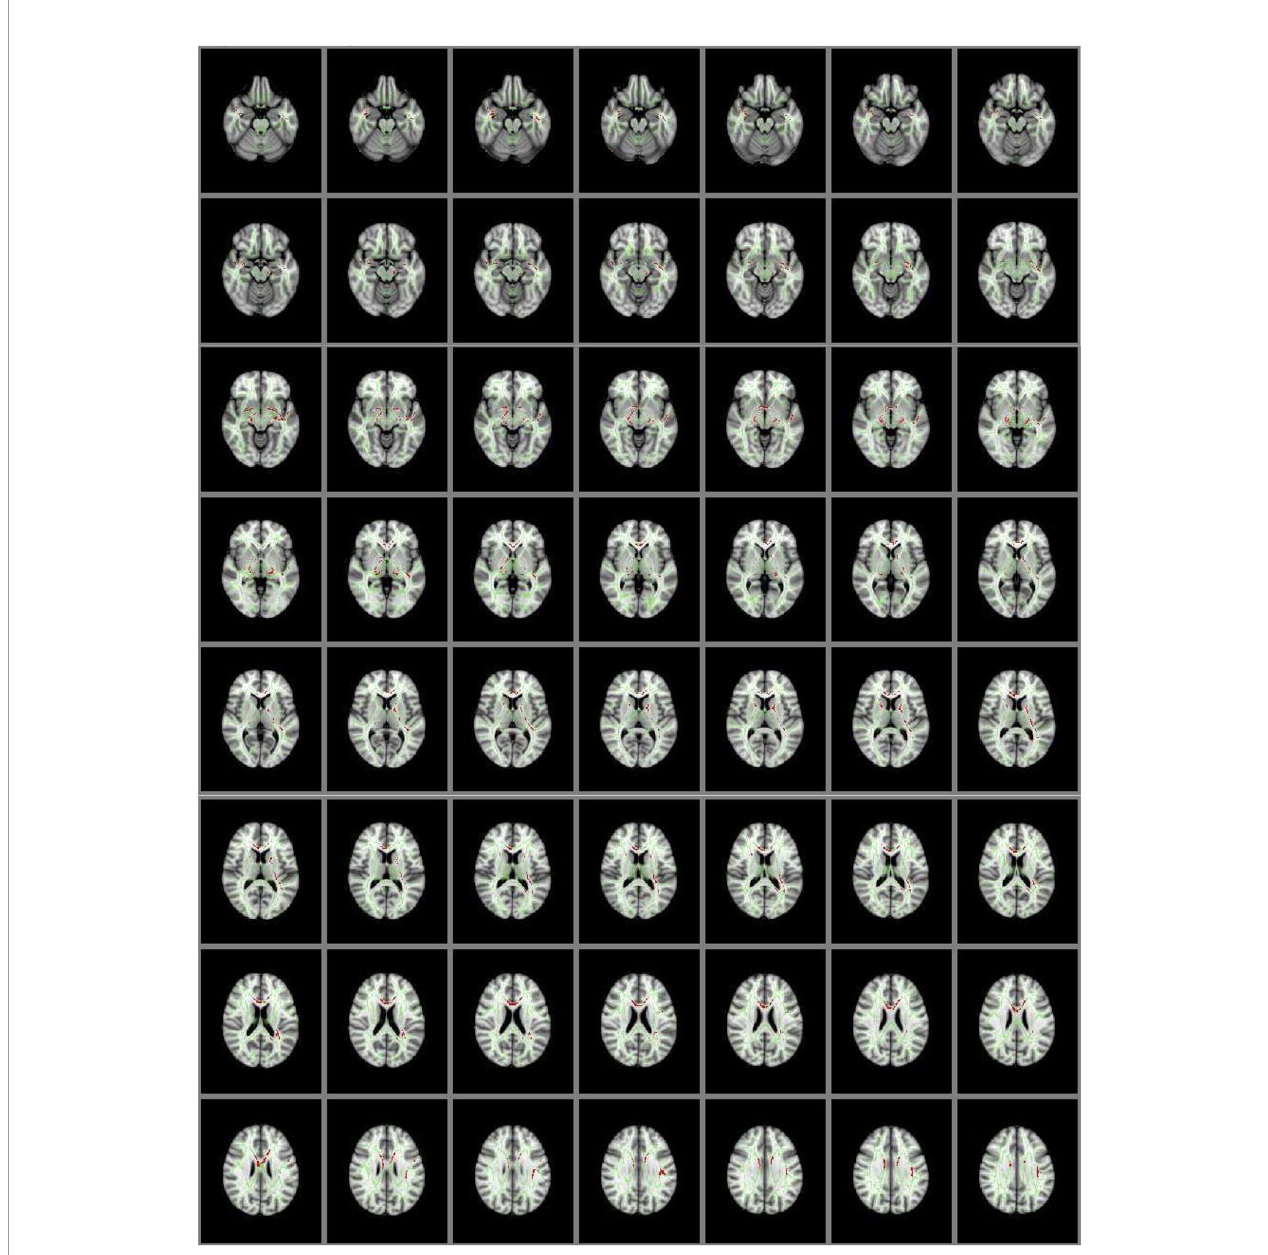
FIGURE 2 | Group Differences in GFA: Controls > NSSI. White matter tracts in red show where controls have signi fi cantly greater GFA than NSSI. This is overlaid on the mean GFA skeleton (light green). Findings were signi fi cant at p <